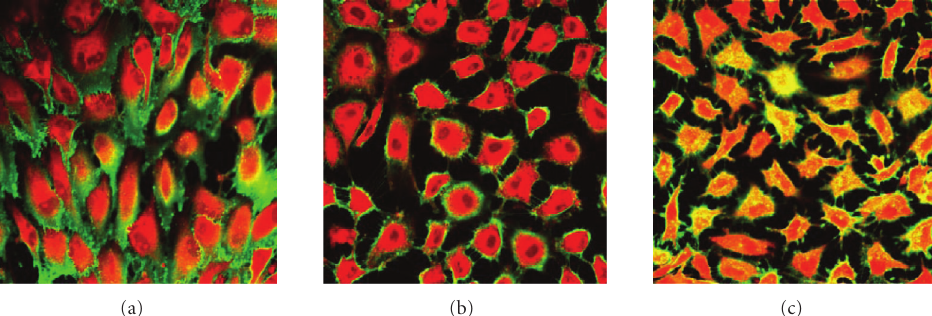
Figure 2: Role of endocytosis on the internalization of FITC-conjugated lectins. PAEC exposed to flow shear stress at 11 dynes/cm 2 and under static conditions under di ff erent temperatures that are permissive for endocytosis (37 ◦ C; control) and nonpermissive (+4 ◦ C). The glycocalyx layer is visualized under the confocal microscope through staining of heparan sulfate with FITC-conjugated lectin (green) and counter stained with CellTracker Orange (red) after di ff erent times in culture. (a) Cells exposed to flow shear stress for 24 hours at +4 ◦ C, (b) cells grown under static condition for 24 hours at +4 ◦ C, and (c) cells grown under static conditions for 24 hour at 37 ◦ C. Internalized FITC stain appears